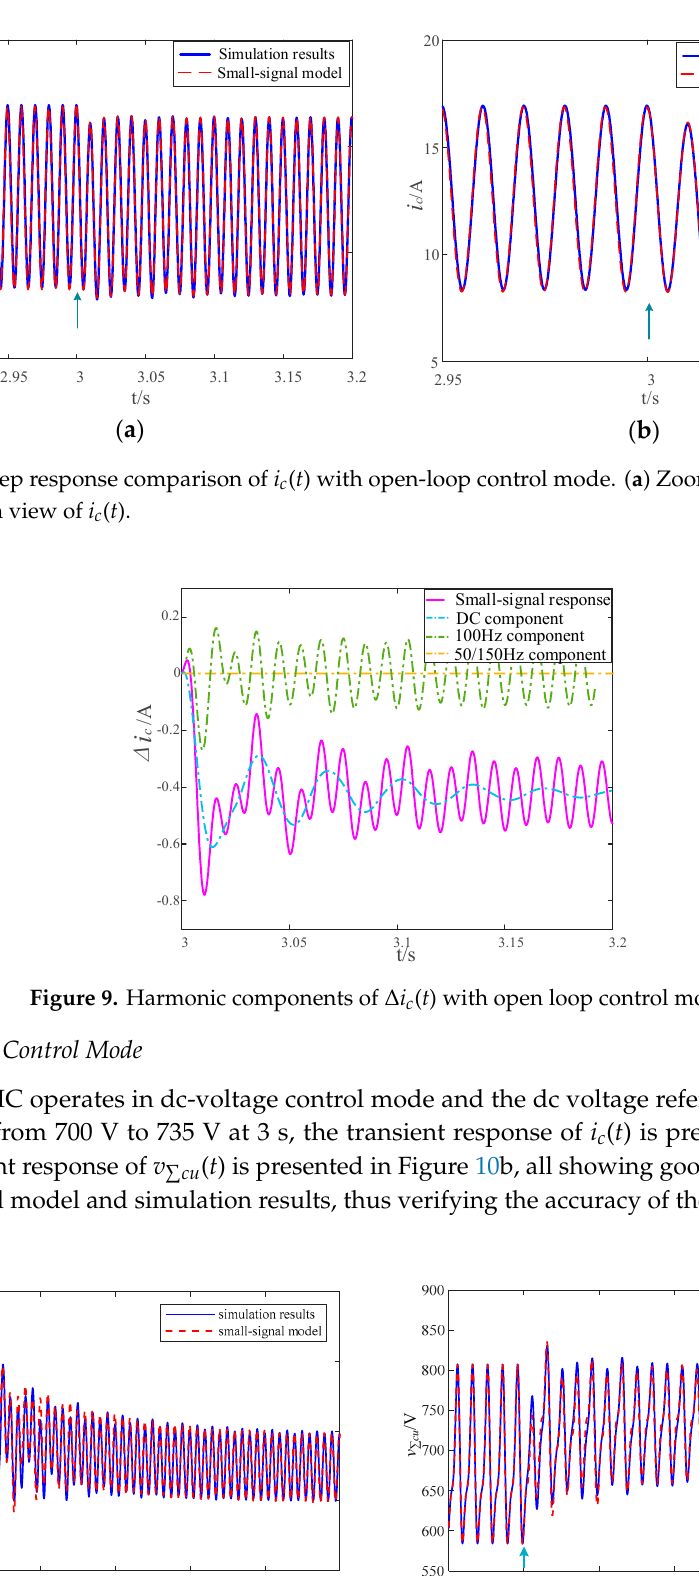
Figure 10. Step response comparison of ( a ) i c ( t ) with dc voltage control mode. ( b ) v ∑ cu ( t ) with dc voltage control mode.